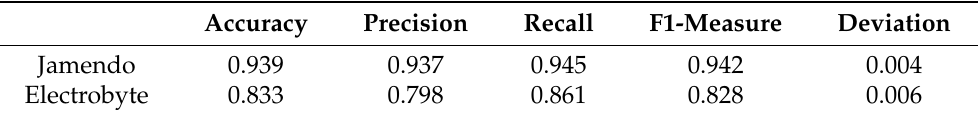
Table 2. Performance of the SVD system on two different